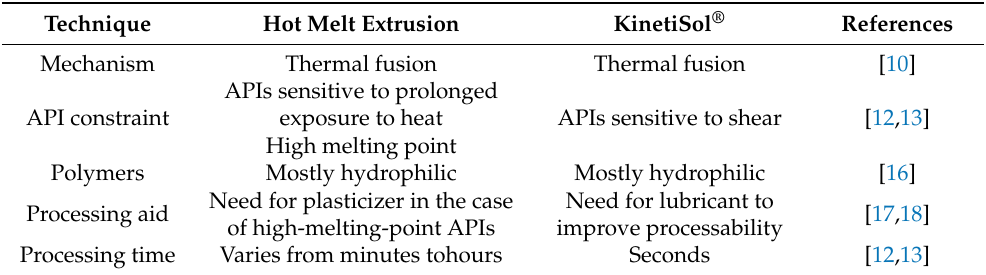
Table 1. A comparison of hot melt extrusion and KinetiSol ®